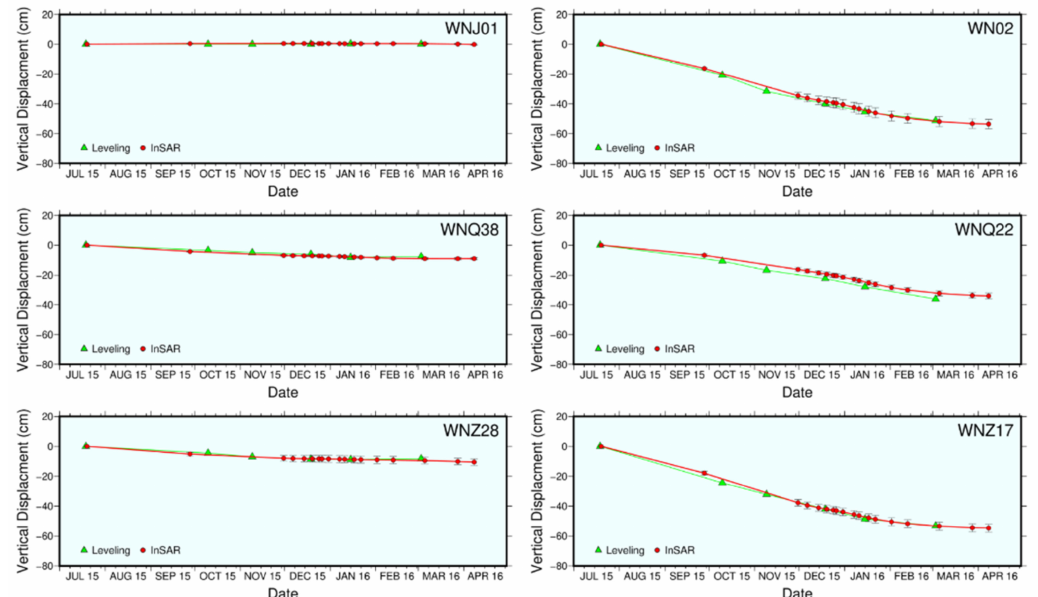
Figure 14. Comparison of time-series subsidence between leveling data and MSBAS results at the selected points of the Wannian site.